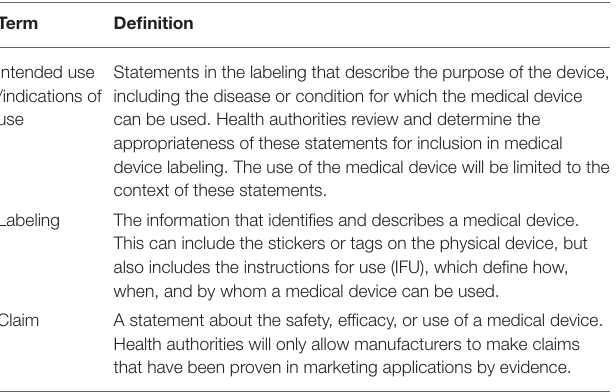
TABLE 3 | Terminology defined: regulated product